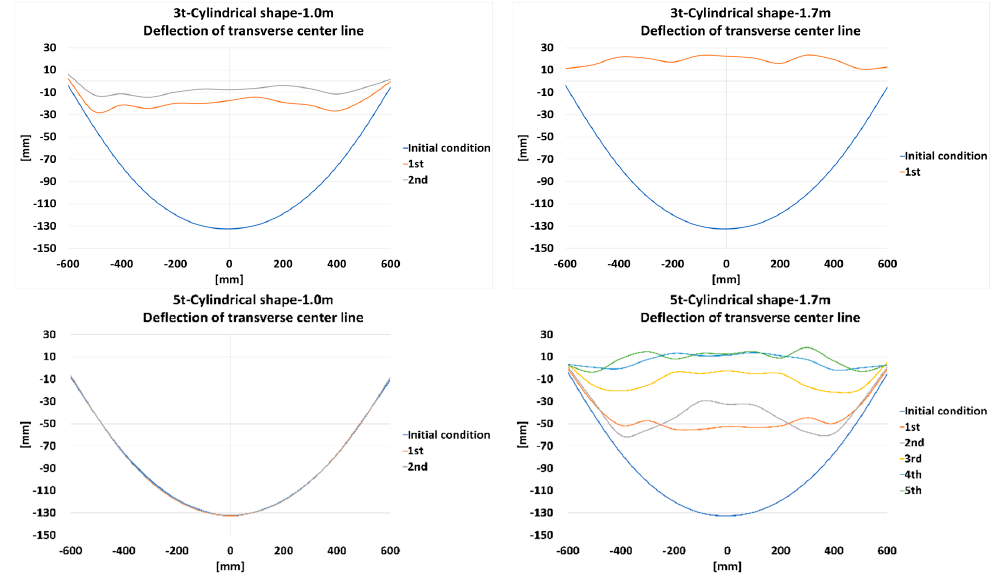
Figure 14. Deflection curves from consecutive drop tests at cylindrical model (height: 1.0, 1.7 m, bottom thickness: 3, 5 mm).